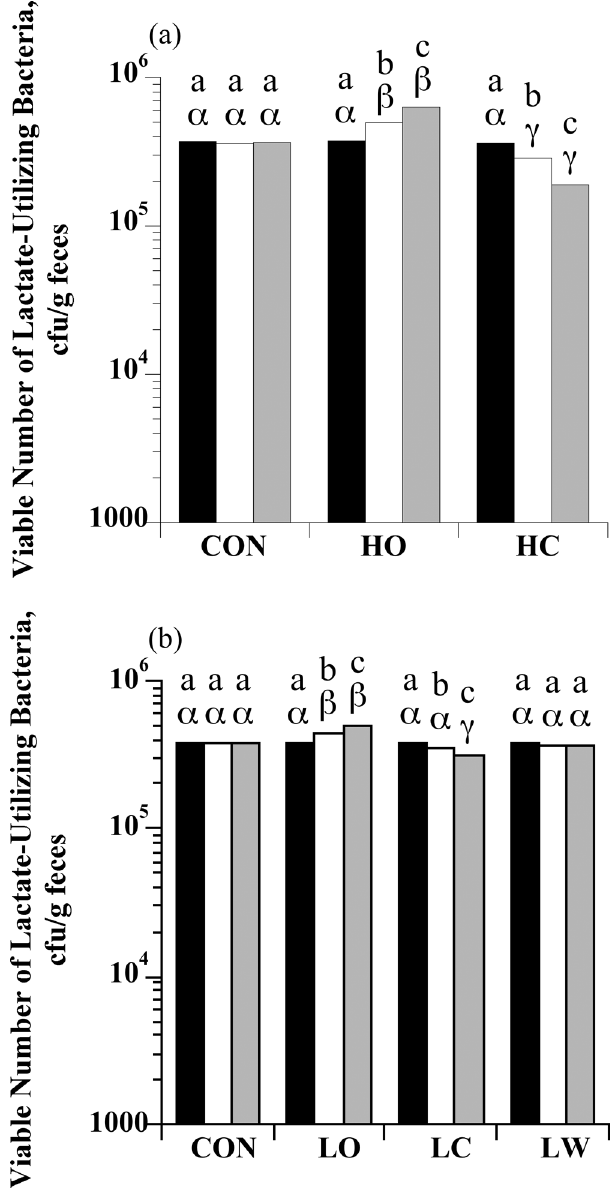
Fig 4. The effect of dietary starch source (corn, oats, and wheat middlings) on the viable number of total lactate-utilizing bacteria in equine feces. (a) Horses were assigned to treatments: hay only (CON; n = 4), high oats (HO; n = 4; 2 g starch/kg BW), or high corn (HC; n = 4; 2 g starch/kg BW). (b) Horses were assigned to treatments: hay only (CON; n = 5), low oats (LO; n = 5; 1 g starch/kg BW), low corn (LC; n = 5; 1 g starch/kg BW), or low wheat middlings (LW; n = 5; 1 g starch/kg BW). An initial sample was obtained at the end of the forage-only feeding period (S0; black bars) before starch sources were introduced. Additional samples were taken on d 6 when horses were receiving 50% of the assigned starch source (S1; open bars) and on d 13 when they were receiving 100% of the assigned starch source (S2; grey bars). Means lacking a common English letter are different within sample day point ( P < 0.05). Means lacking a common Greek letter are different between sample days within a treatment ( P < 0.05); (a) Treatment: P = 0.0001, sample day: P = 0.3902, and treatment × sample day: P < 0.0001; Pooled SEM: treatment = 0.02121, sample day = 0.0165, and treatment × sample day = 0.0287 (log 10 transformed); (b) Treatment: P = 0.0002, sample day: P = 0.9747, and treatment × sample day: P < 0.0001; Pooled SEM: treatment = 0.0114, sample day = 0.0073, and treatment × sample day = 0.0145 (log 10 transformed).